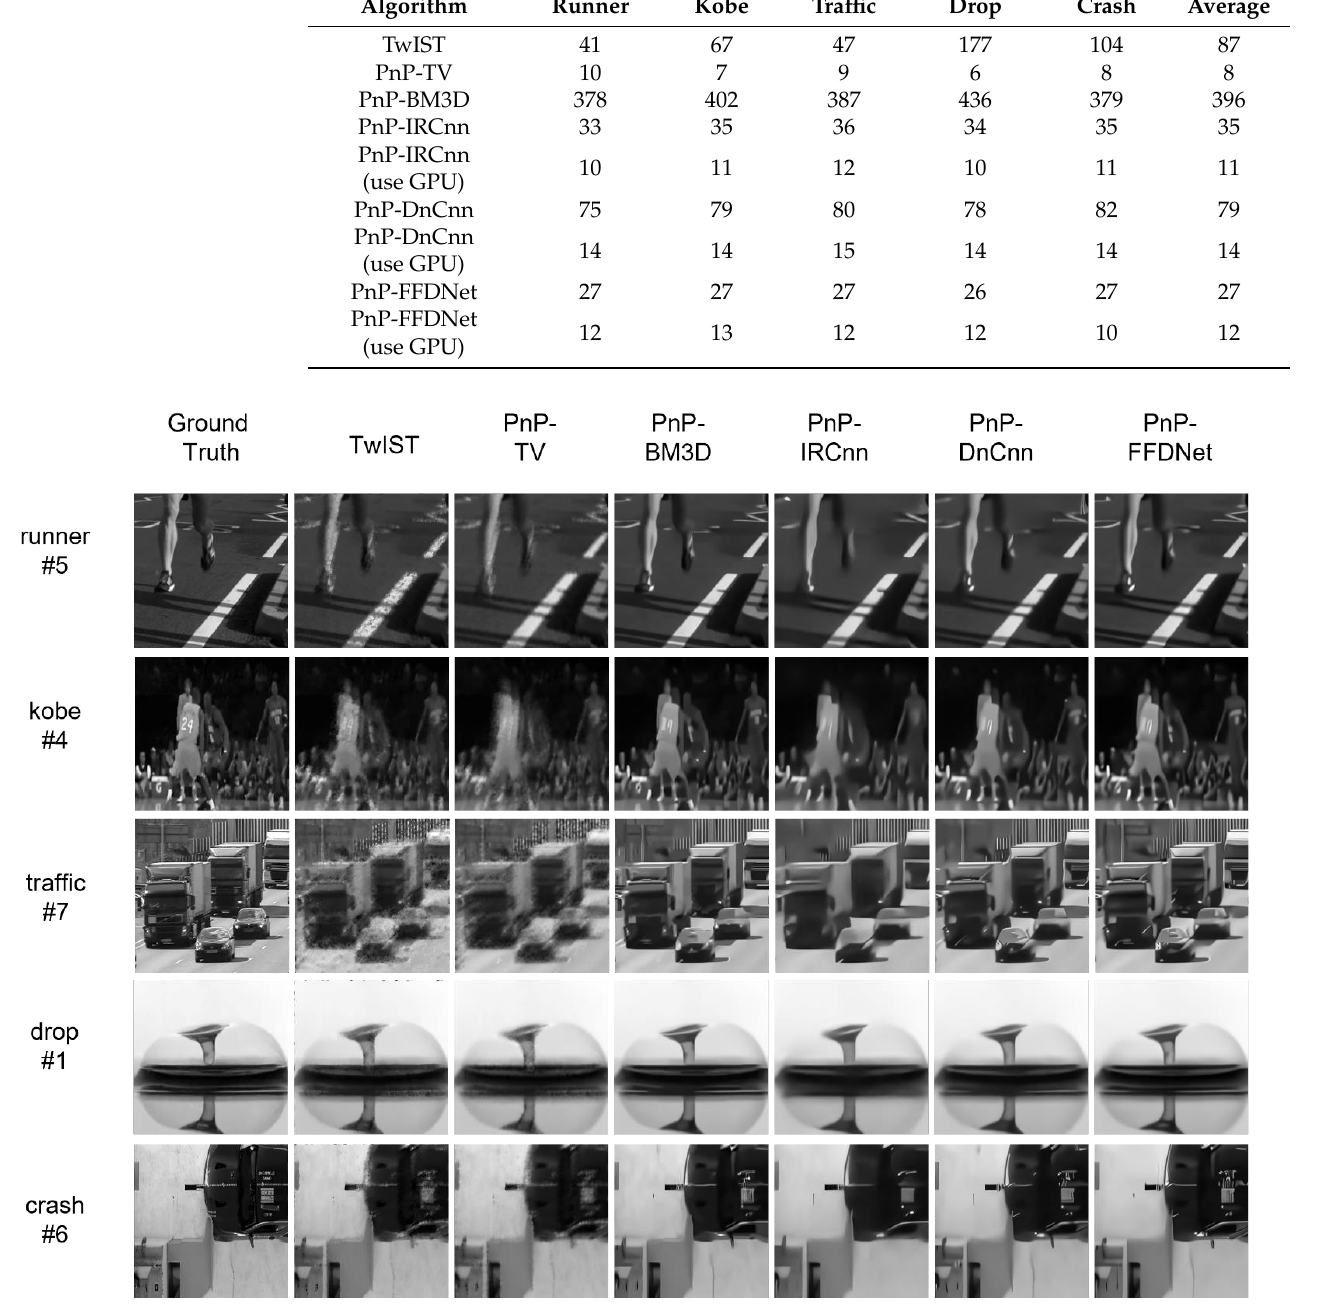
Table 3. The execution time (second).